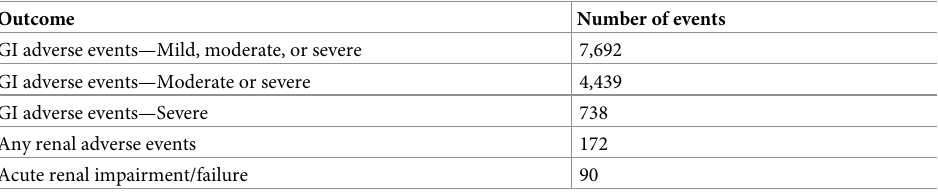
Table 3. Number of adverse events in the total sample. Total N